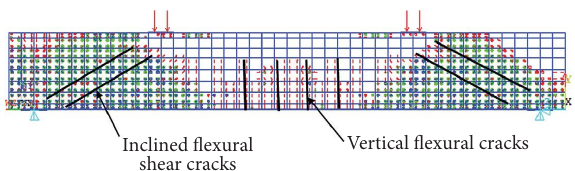
Figure 7: ANSYS simulation showing cracks in a concrete beam.